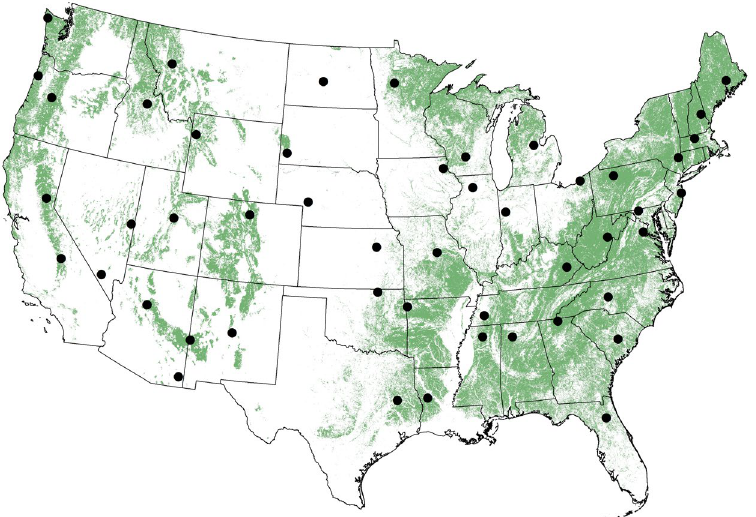
Figure 1. Locations of 49 sites sampled for wood δ 15 N in the continental U.S.A. Woody cover (green) is